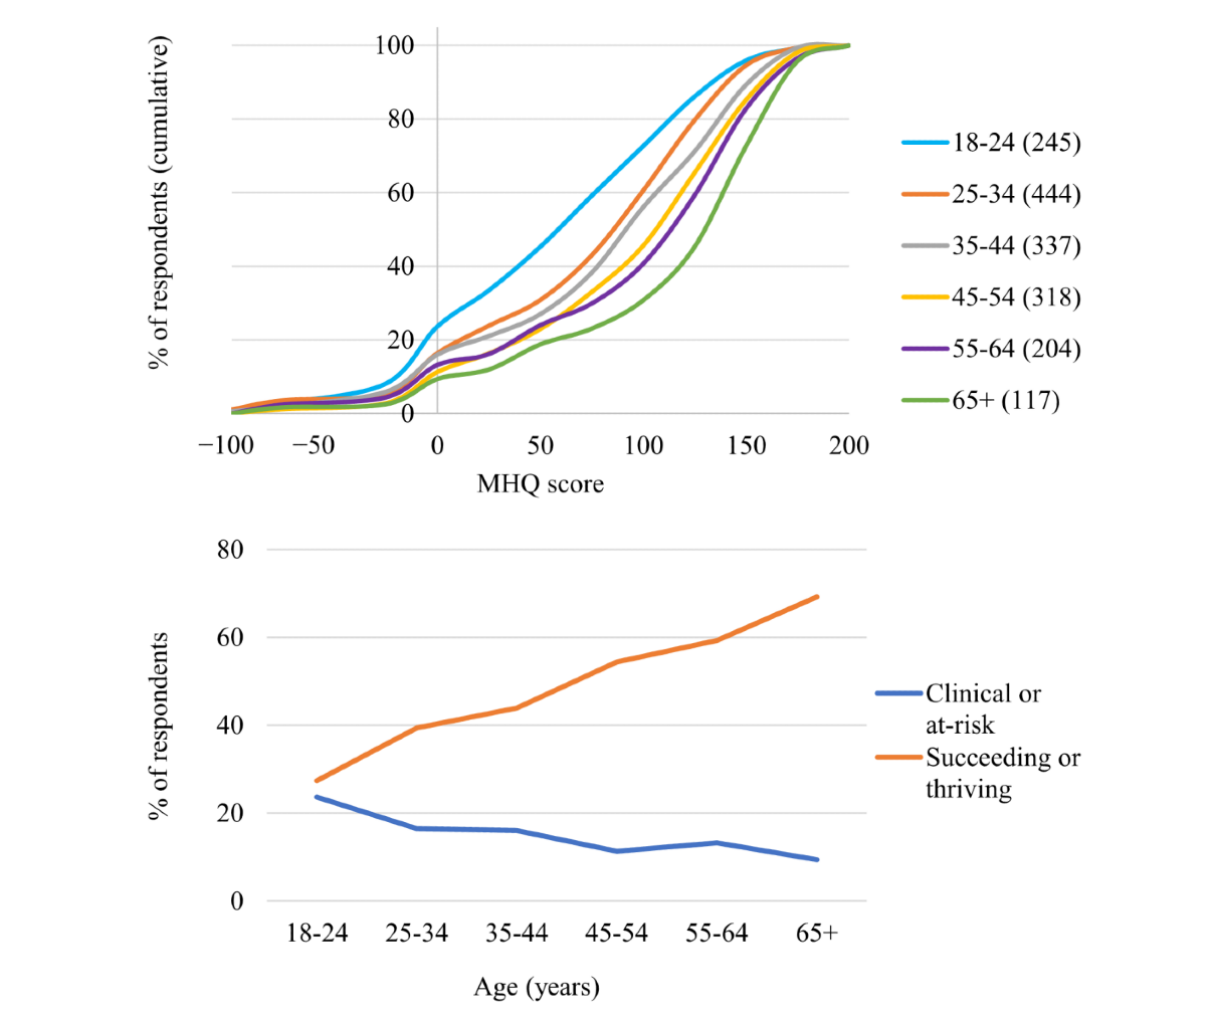
Figure 7. Distribution of Mental Health Quotient scores across ages. Shows both the cumulative percentage of respondents across the Mental Health Quotient score range for each age bracket (N values for each age bracket shown in the legend) and the linear increase in the proportion of succeeding or thriving (Mental Health Quotient scores above 100) and the decrease in the proportion of at-risk or clinical (Mental Health Quotient scores below 0) from younger to older age groups. MHQ: Mental Health